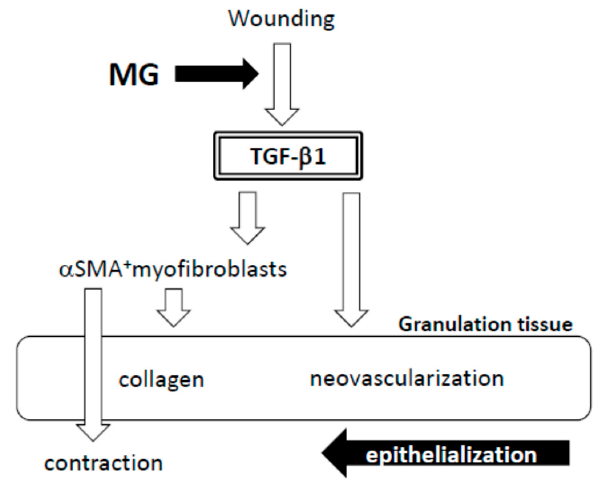
Figure 8. Hypothesis of wound healing by autologous micrograft.